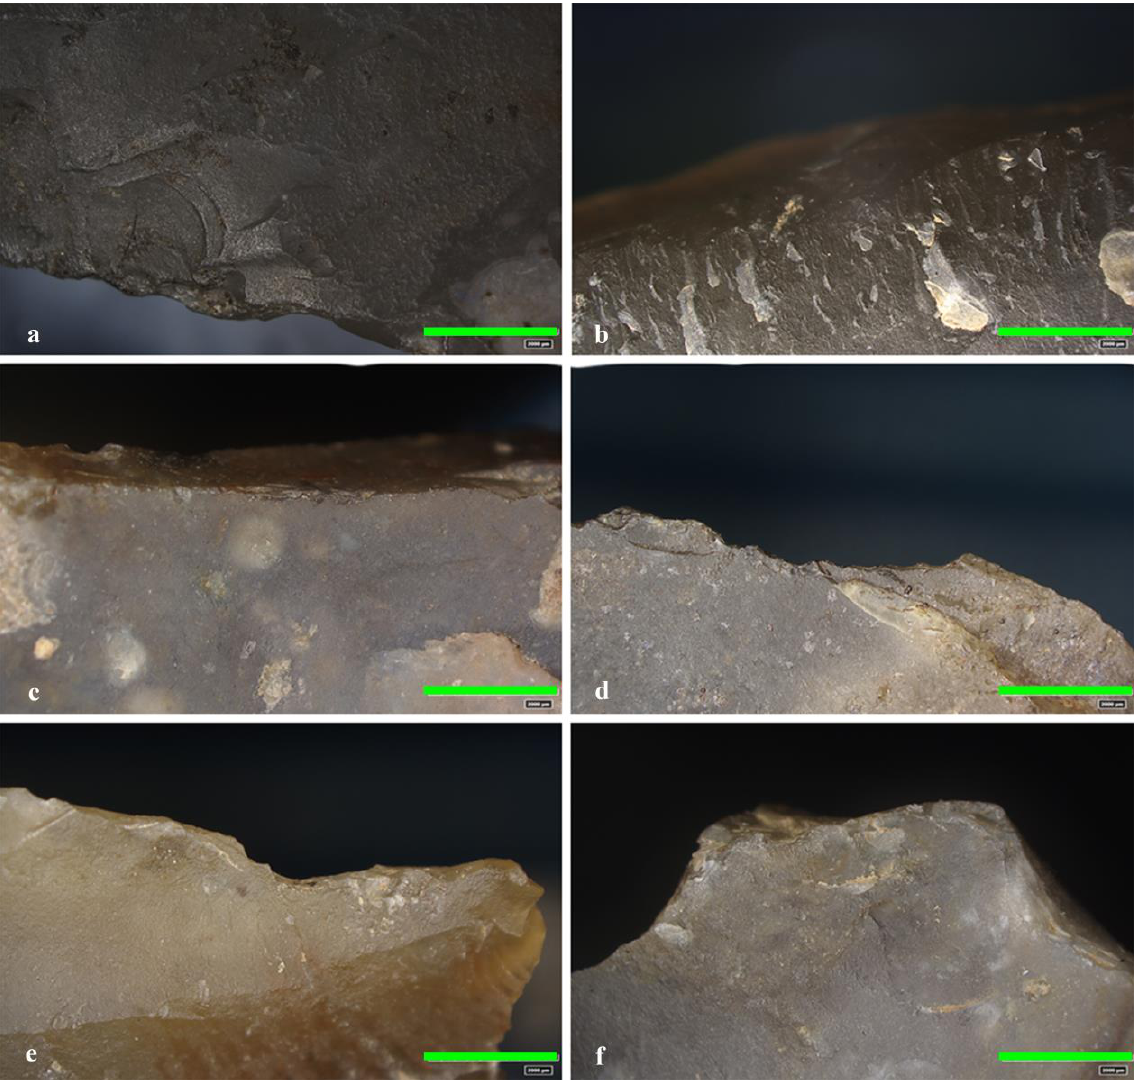
Figure 18. Samples with noted different post-depositional surface modifications like mechanical alterations, trampling, edge rounding, and edge removals not created by use. Trench C, a) sample 36; trench B: b) sample 32; Slope 1: c) sample 24; d) sample 25; e) sample 22, f) sample 27, scale bar equal to 2000